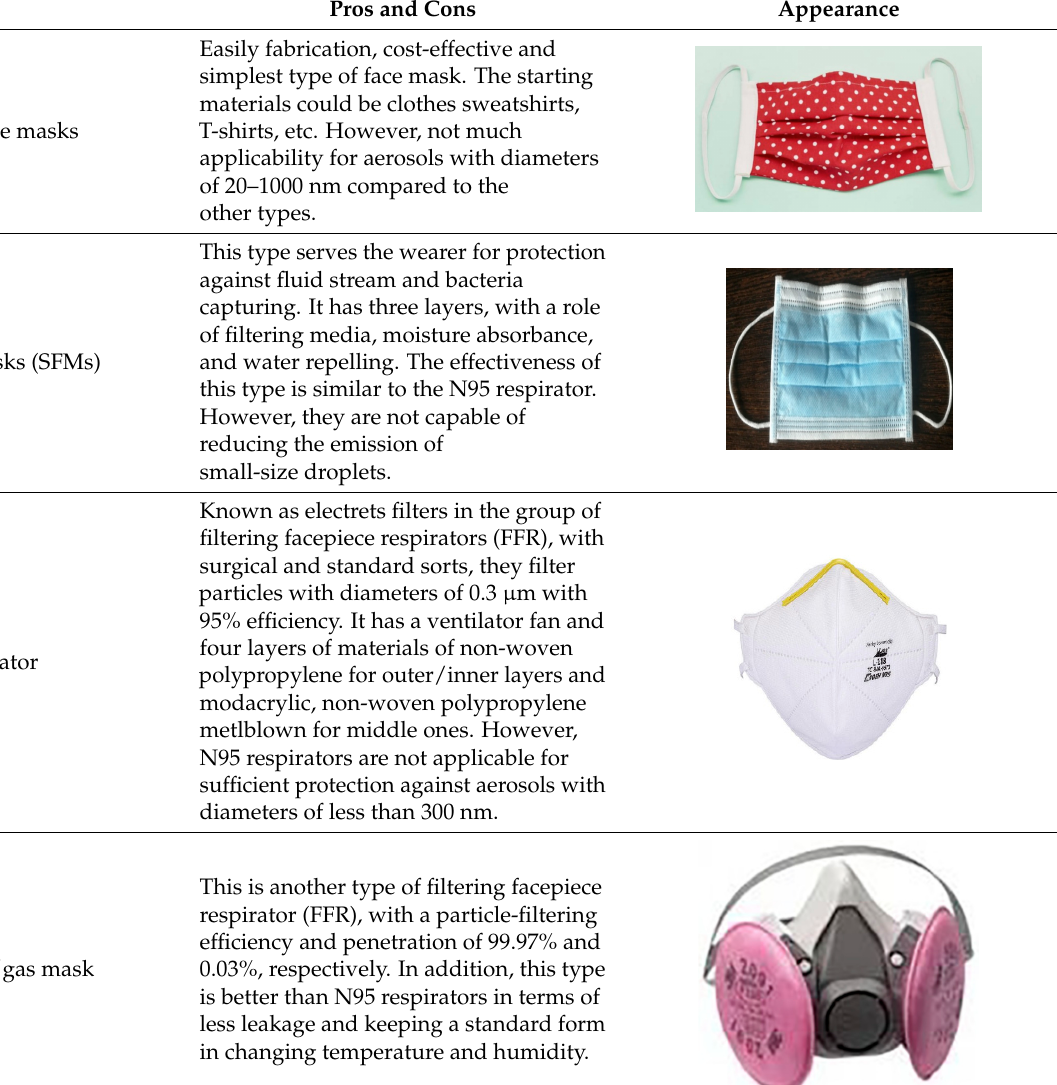
Table 2. Introduction to types of face masks [1,17–22].